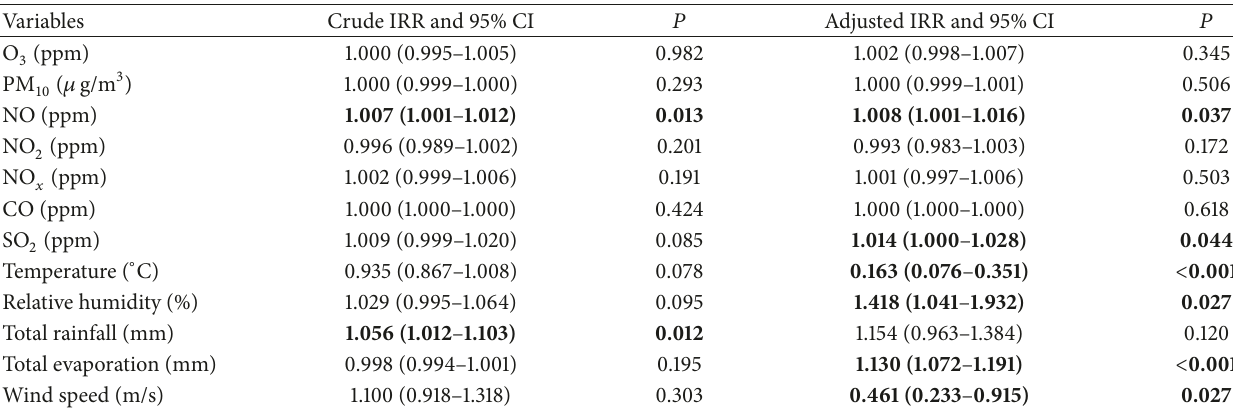
Table 3: Results of crude and adjusted negative binomial regression and of the effect of pollutants and climate factors on respiratory hospital admissions (ratio of increase in hospital admissions in day per unit of increase in pollutants and climate factors daily average) in the epidemic periods.